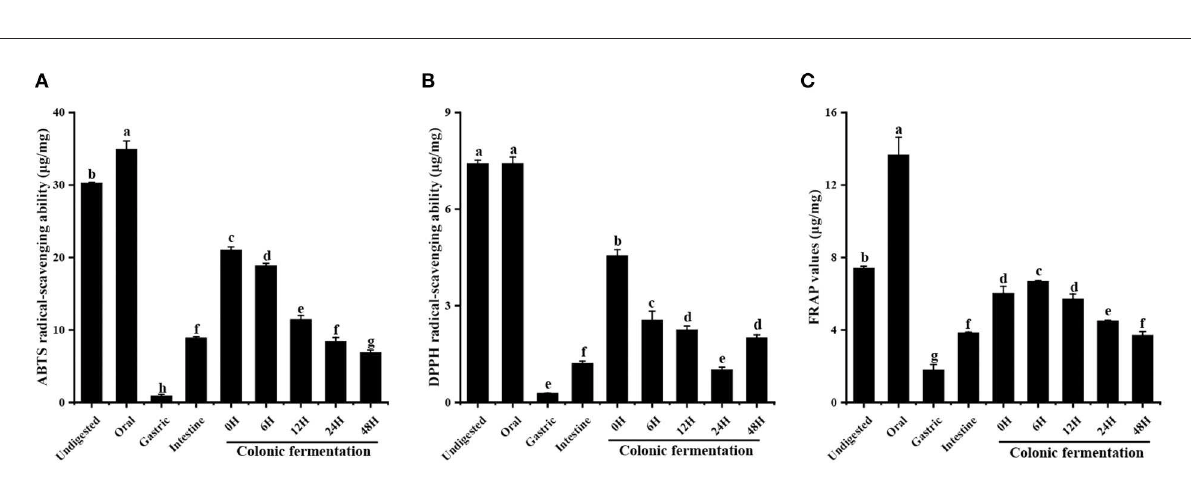
Figure 4A. When compared to the undigested stages (5.73 ± 0.96 µ g/mg), the inhibitory ability of FJR continuous reduction to 0.49 ± 0.02 µ g/mg. In contrast, the inhibitory ability of